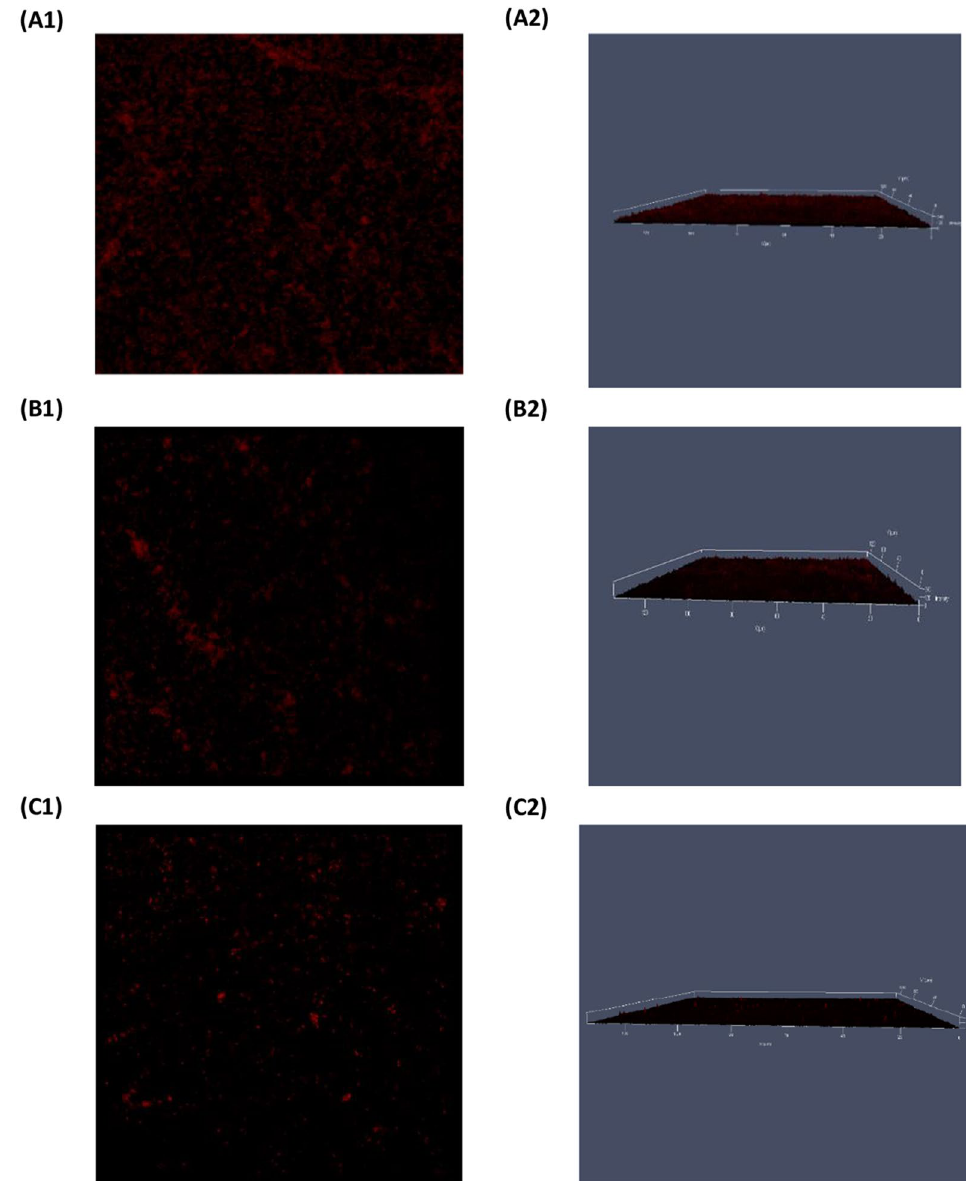
Fig. 7 CLSM images of SYPRO ® Ruby‑stained biofilms obtained after 24 h growth of P. aeruginosa . (1) refers to 2D, and ( 2 ) refers to the 2.5D view